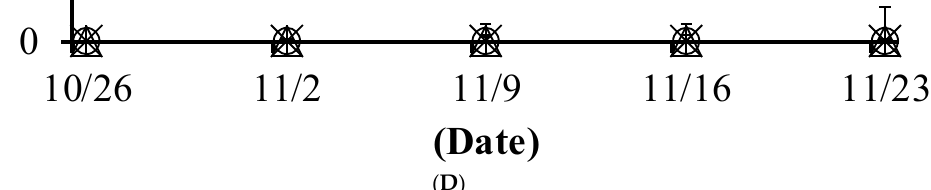
Figure 4. Changes in the nitric ion and ammonium ion content of hydroponic solutions under different fertilization methods. Error bars on vertical columns on bars indicate standard error ( n = 3). ( A , B ): Summer, ( C , D ): Autumn. OF (organic fertilizer): corn steep liquor (CSL) applied as organic fertilizer at the same amount of total nitrogen as that in the half unit of Otsuka A formula; OF2: CSL applied at twice the amount of total nitrogen in OF; CF (chemical fertilizer): half unit of Otsuka A formula. The level of dissolved oxygen in OF2 was significantly decreased compared with the other two treatments in both summer and autumn cultivation periods (Figure